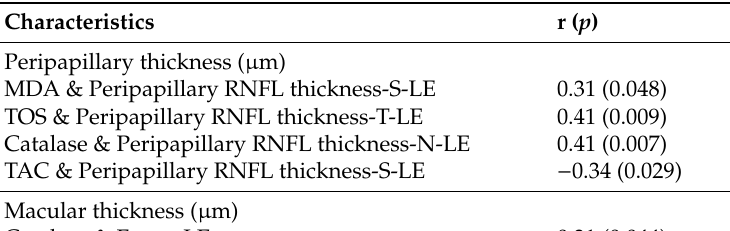
Table 4. Pearson’s rank correlations (r) among patients with